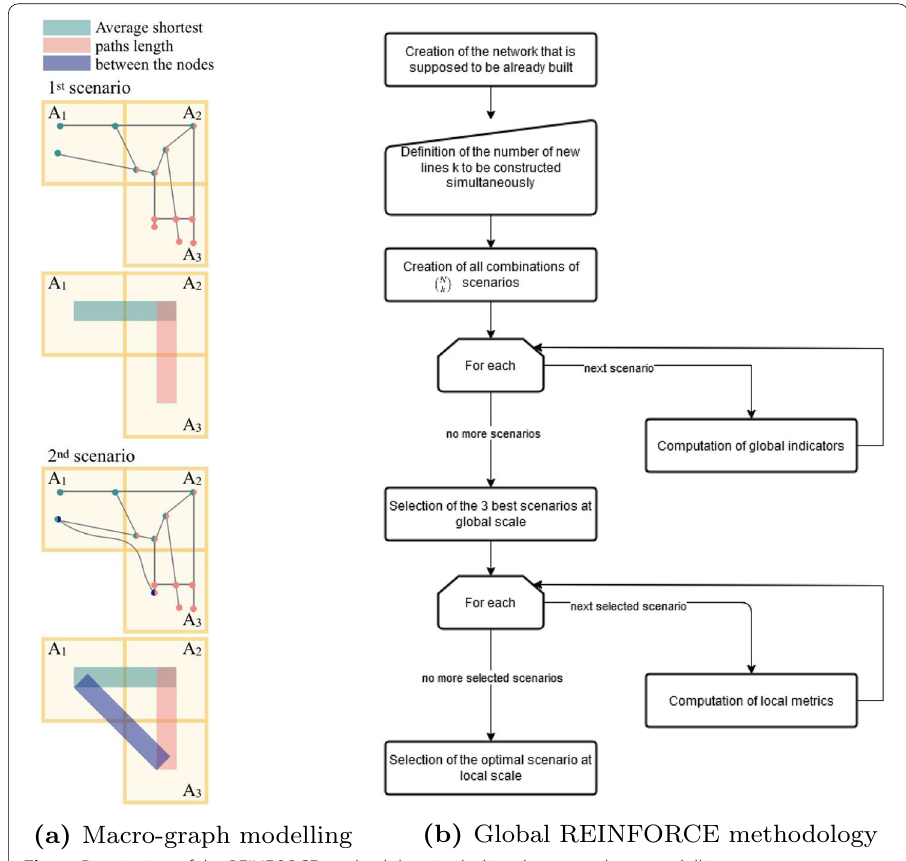
Fig. 1 Description of the REINFORCE methodology including the macro‑layer